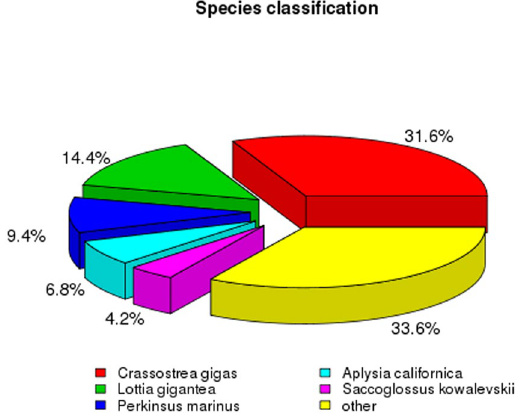
Figure 4. Species distribution of sequences matched to the Nr database.